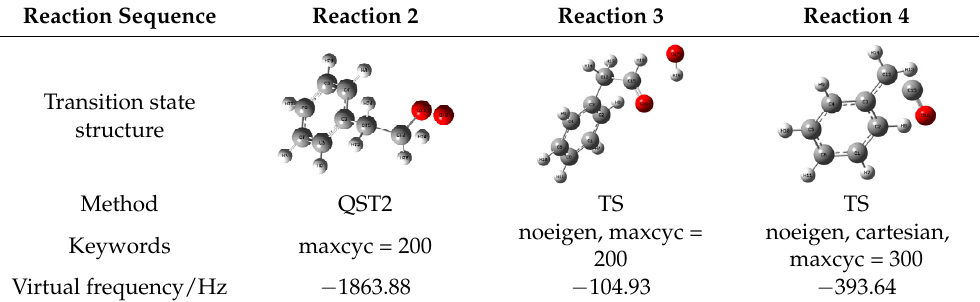
Table 3. Transition state search of path 1.